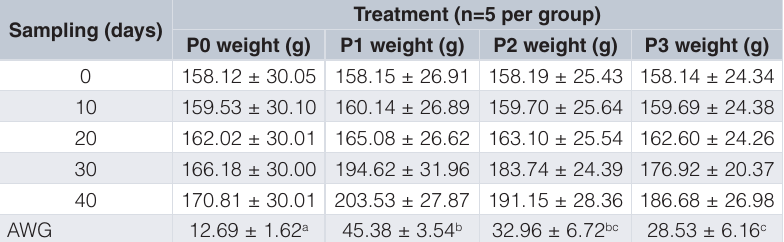
Table 2. Average and absolute weight (g) of female broodstock blue swimming crabs, P. pelagicus (Linnaeus, 1758), with a formulated diet of vitamin E supplementation at different doses.